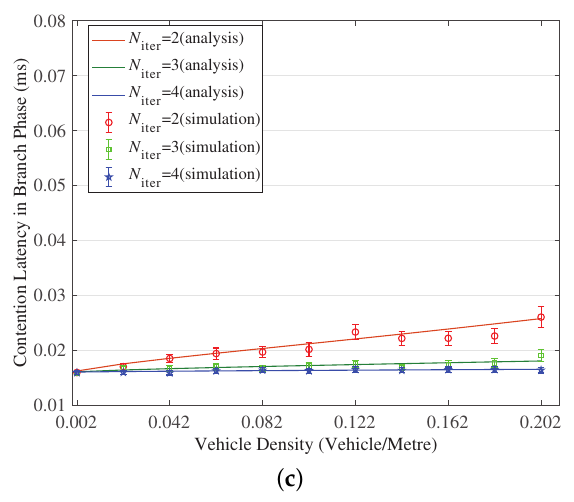
Figure 6. Validation of the model for contention latency in Branch Phase. ( a ) When ( N iter , N part ) = (2, 3); ( b ) When ( N iter , A ) = ( 2,2 ) ; ( c ) When ( N part , A ) = ( 4,2 ) .